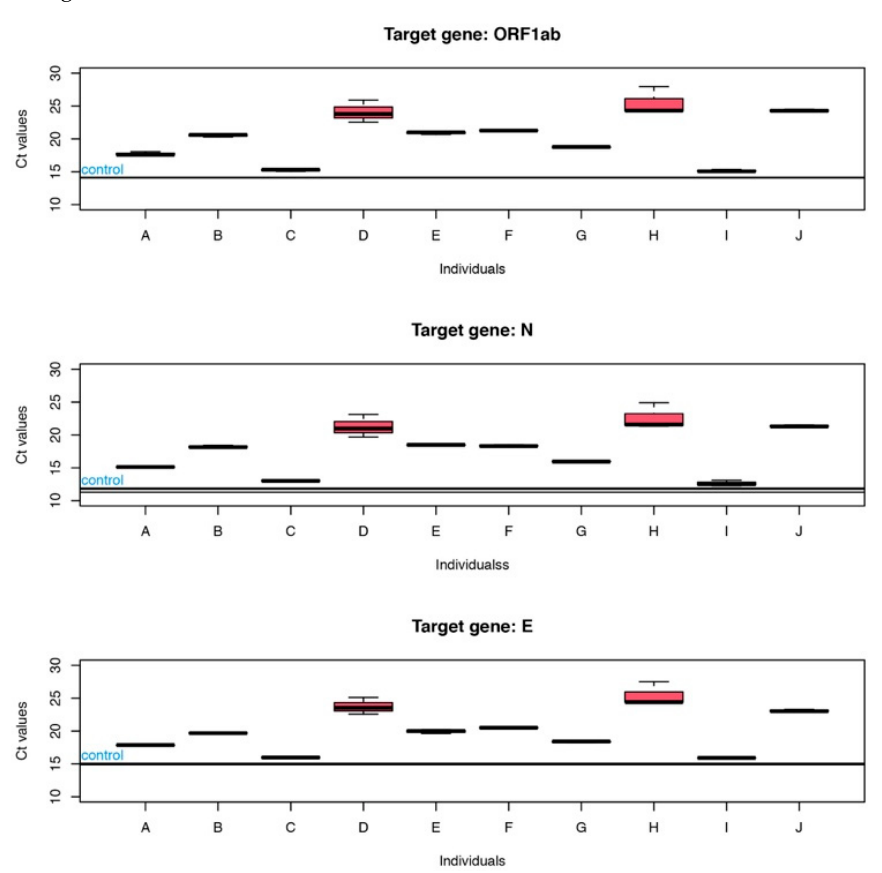
Figure 1. Ct values relative to ORF1ab, N and E genes, for reactions in the presence of saliva (5 µ L) from ten different individuals (A to J). Horizontal lines, identified as control, refer to the Ct values of control reaction with no saliva.